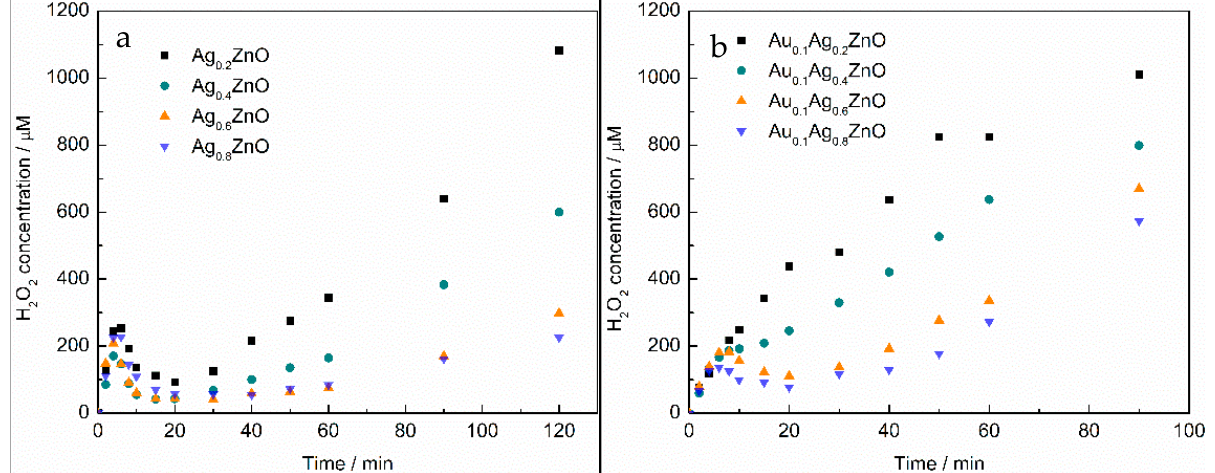
Figure 7. ( a ), Time-concentration profile of generation of H 2 O 2 on Ag/ZnO. ( b ), Time-concentration profile of generation of H 2 O 2 on Au-Ag/ZnO.